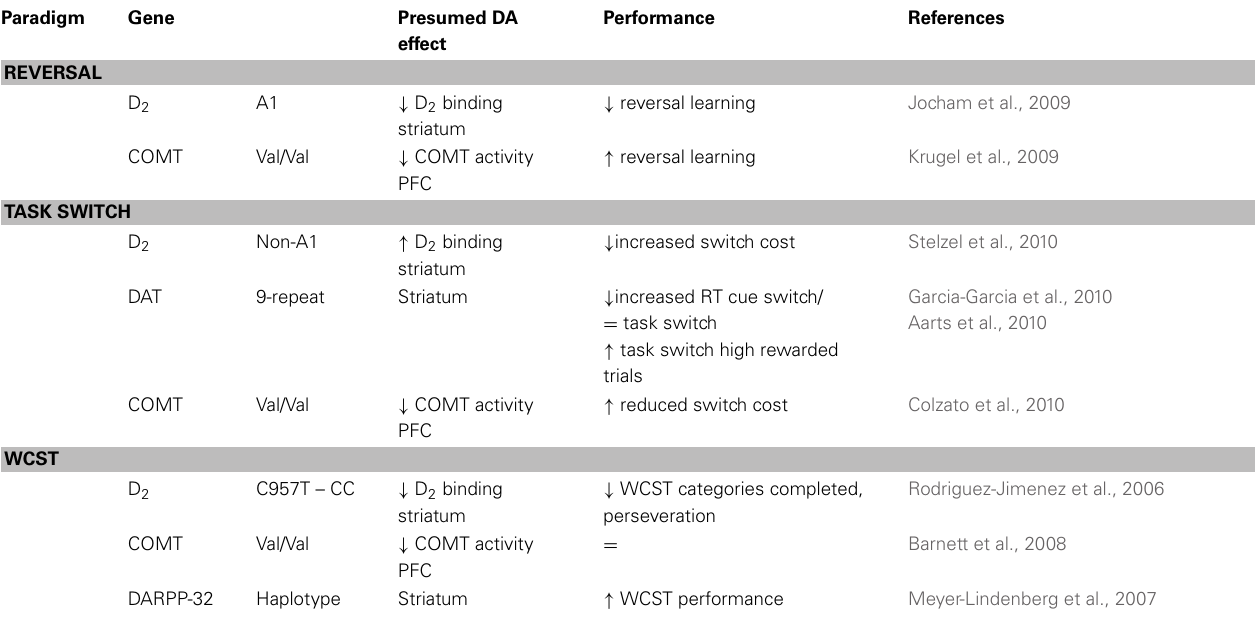
Table 3 | Effects of polymorphisms in dopamine related genes on cognitive flexibility in human subjects.